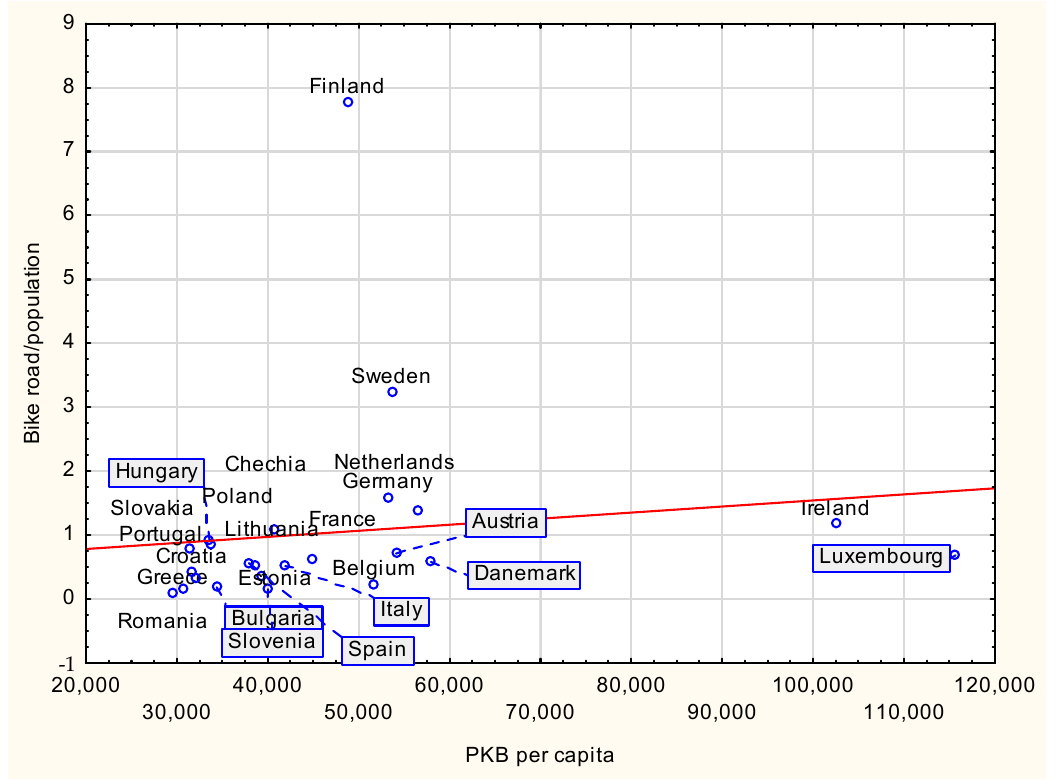
Figure 10. Scatter plot between GDP per capita and average length of bikeways per 1000 residents in smart cities. Source: author’s analysis.